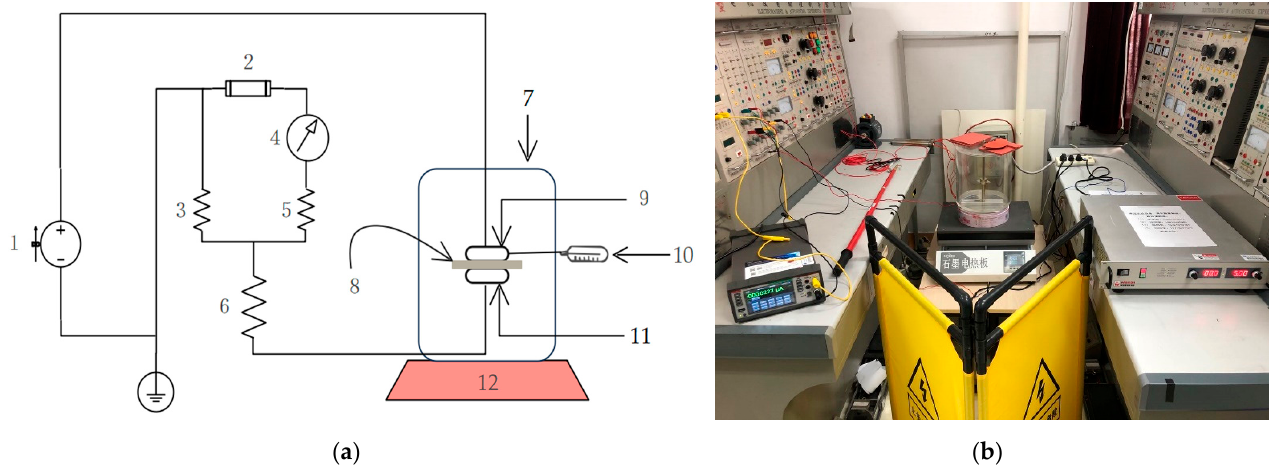
Figure 1. Experimental setups. ( a ) Schematic diagram. (1) high voltage direct current power supply; (2) fuse; (3) divider resistor; (4) digital multimeter; (5) divider resistor; (6) divider resistor; (7) experimental tank; (8) test sample; (9) high voltage electrode; (10) thermocouple; (11) grounded electrode; (12) hotplate; ( b ) photo of the experimental setup.